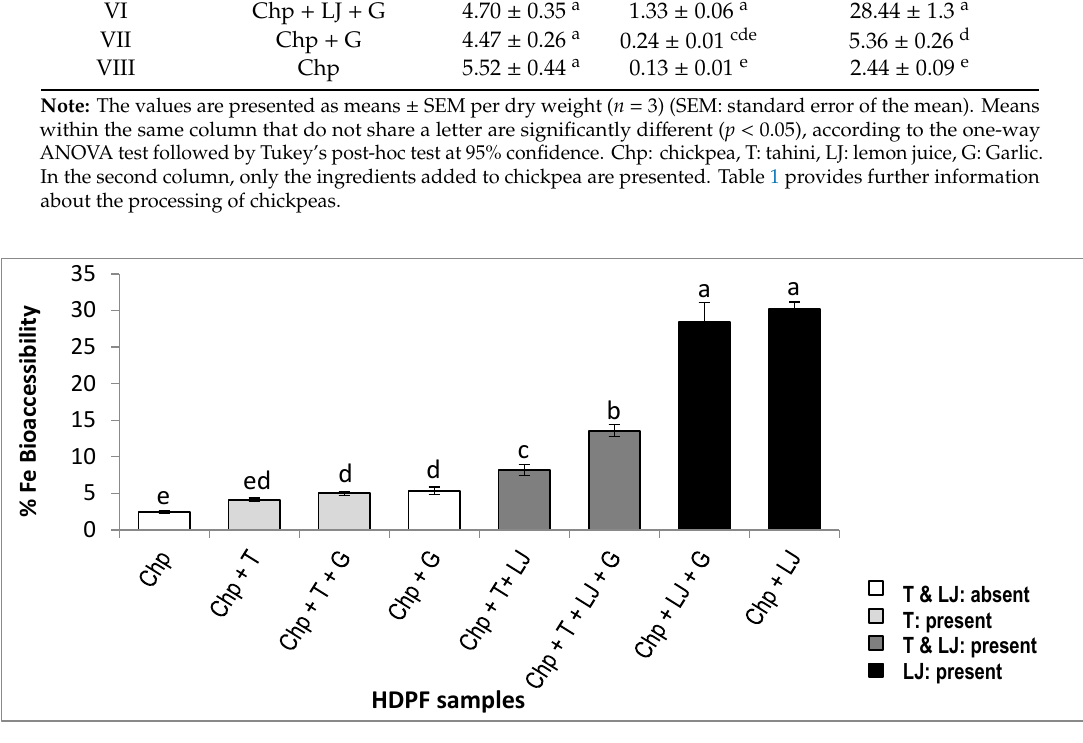
Figure 1. Percentage of iron bioaccessibility (dialyzable iron content in mg/100 g divided by the total iron content in mg/100 g) in the eight samples of HDPF chosen based on the Hadamard matrix, circular permutation by the right. (HDPF: hummus with different processing and formulation). Results